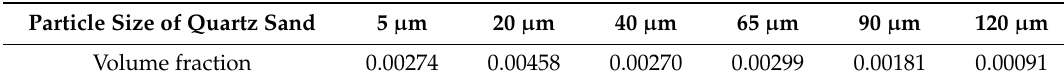
Table 3. Particle size composition.